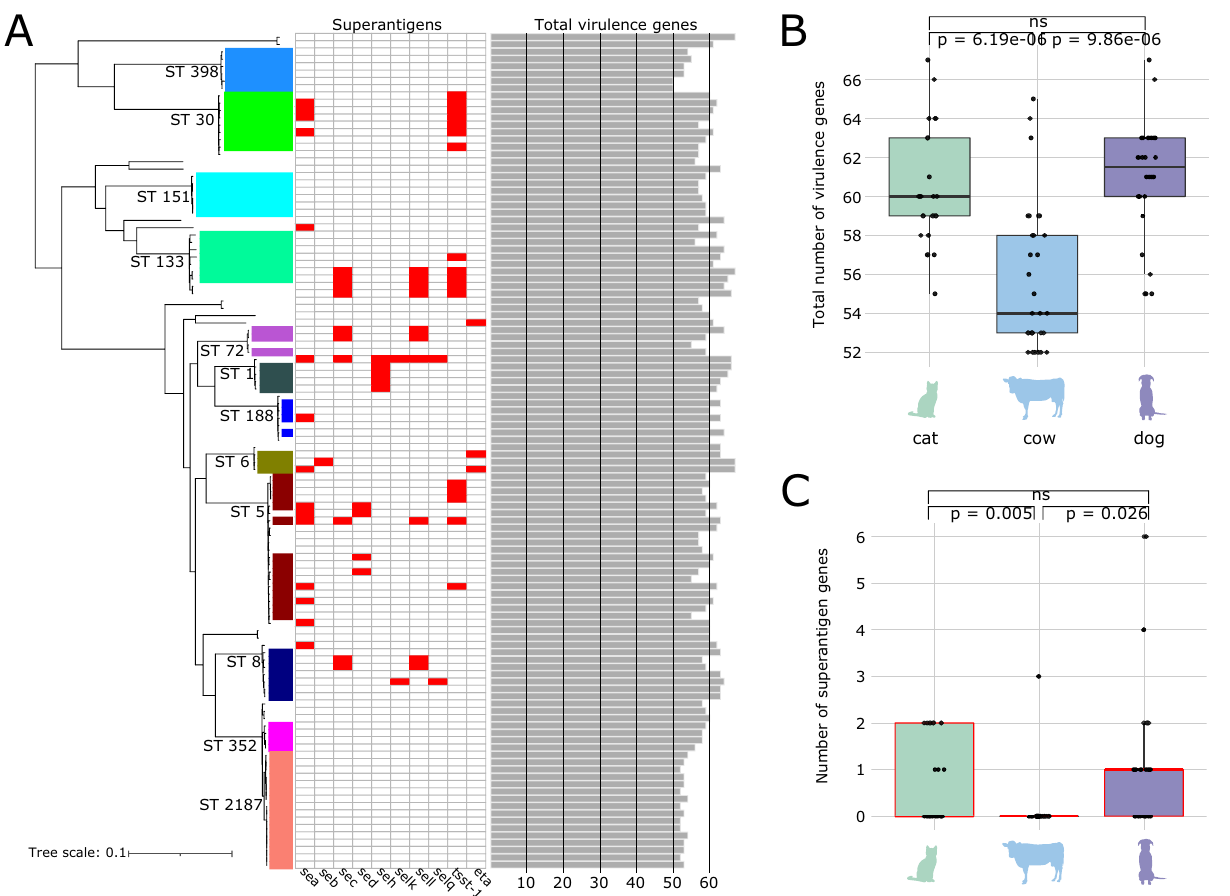
Figure 3. Virulence profiles of animal-associated S. aureus in New England. ( A ) Phylogenetic distribution of superantigen genes (shown in presence [red] or absence [white] matrix) and total number of virulence genes (shown in bar plots). ( B ) Number of virulence genes per S. aureus genome in cats, cows and dogs. ( C ) Number of superantigen genes per S. aureus genome in cats, cows and dogs. Significance was estimated using Welch’s